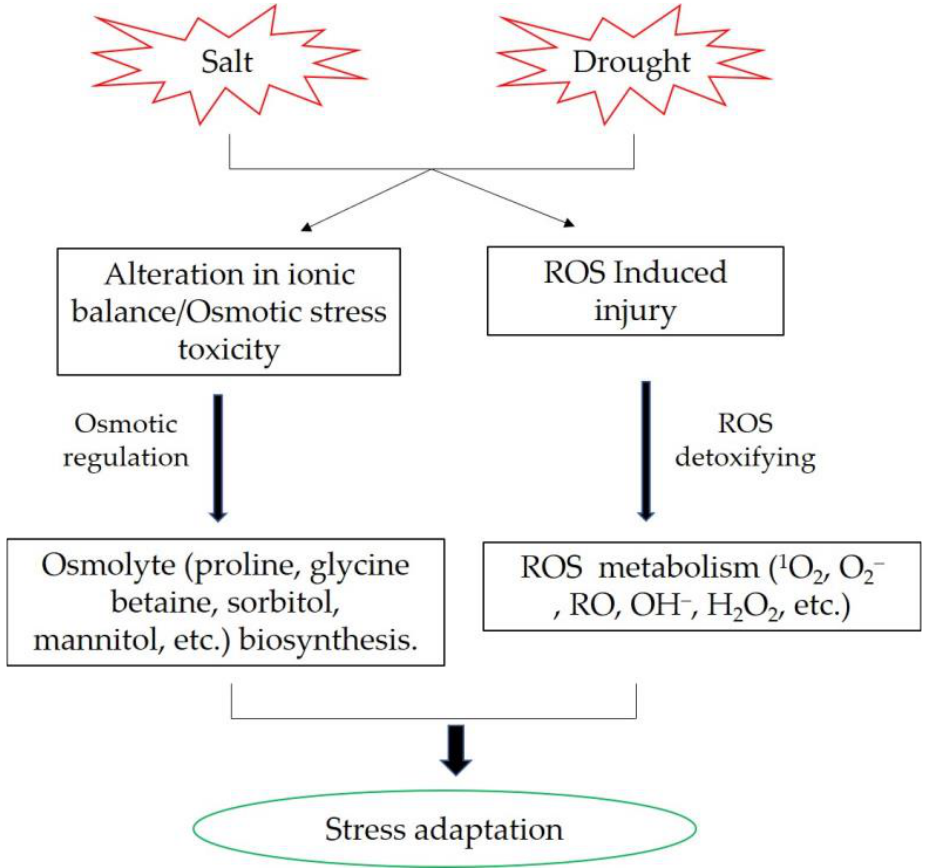
Figure 1. The common mechanisms involved in rice salt and drought stress responses.